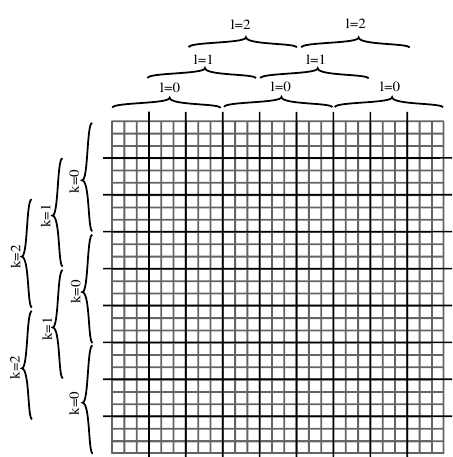
Figure 8. Area of plenoptic image processed by each basic component ( l , k ) .